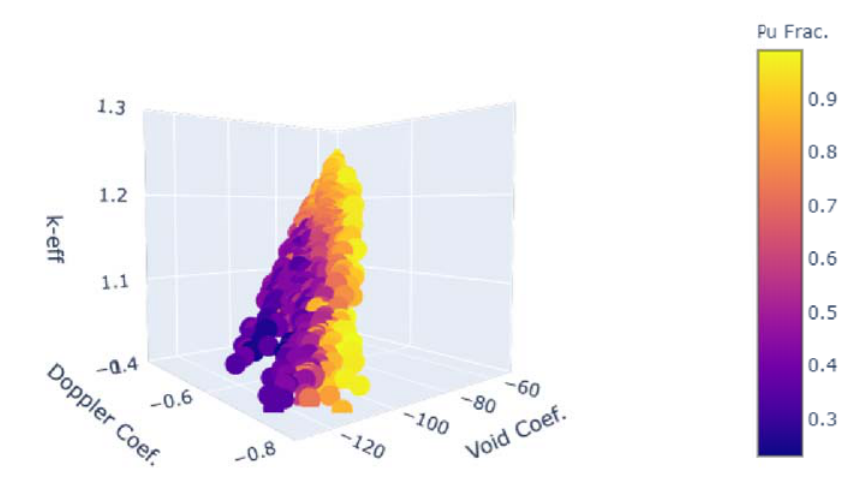
Figure 5: Pareto front for ROM